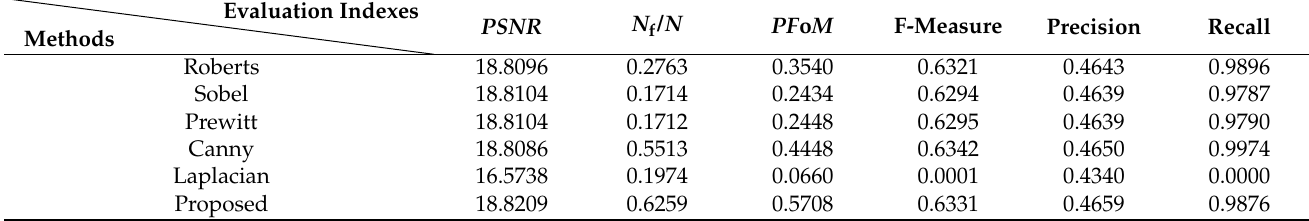
Table 2. The evaluation indexes scores of multiple edge detection methods for the infrared image.